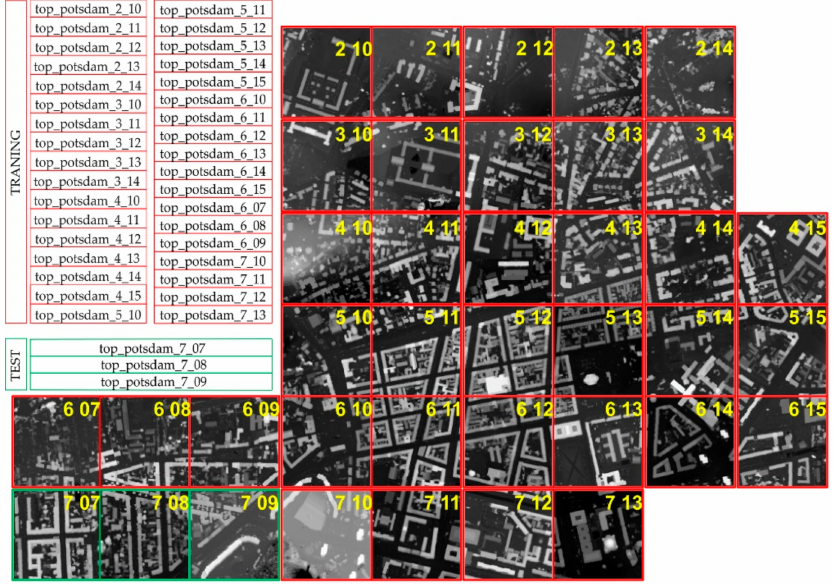
Figure 3. Digital surface model (DSM) patches of the Potsdam dataset: training (red) and test (green)